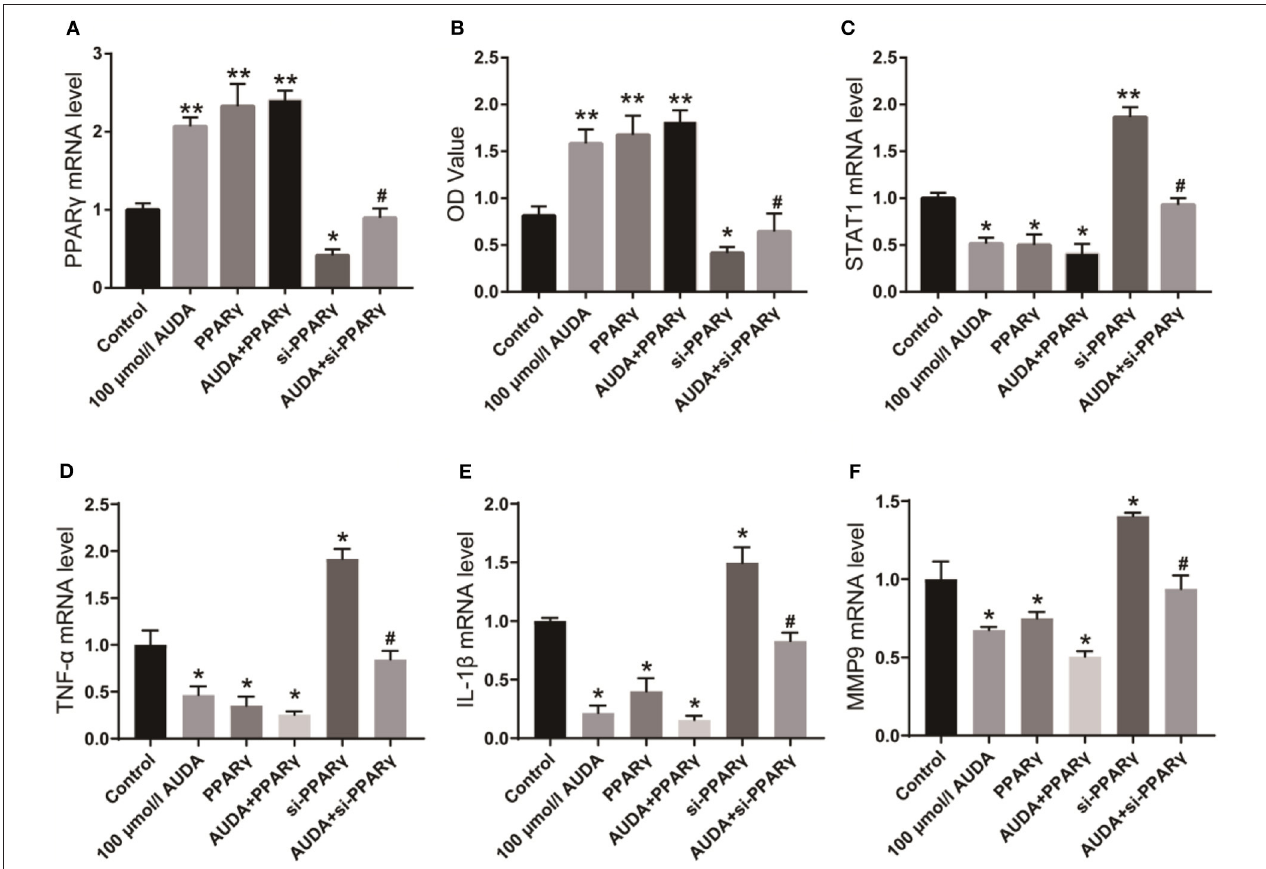
FIGURE 1 | AUDA inhibited JAK/STAT1 signaling pathway by upregulating PPAR γ . (A) The expression of PPAR γ in human coronary artery endothelial cells was detected by qPCR; (B) The proliferation of coronary artery endothelial cells in each group was determined by CCK-8; (C) The expression of STAT1, a key protein in the downstream pathway of PPAR γ was detected by qPCR. The mRNA levels of TNF- α (D), IL-1 β (E) , and MMP-9 (F) in each group were detected using qPCR. * P < 0.05, ** P < 0.05 vs. control group, # P < 0.05 vs. 100 µ mol/L AUDA